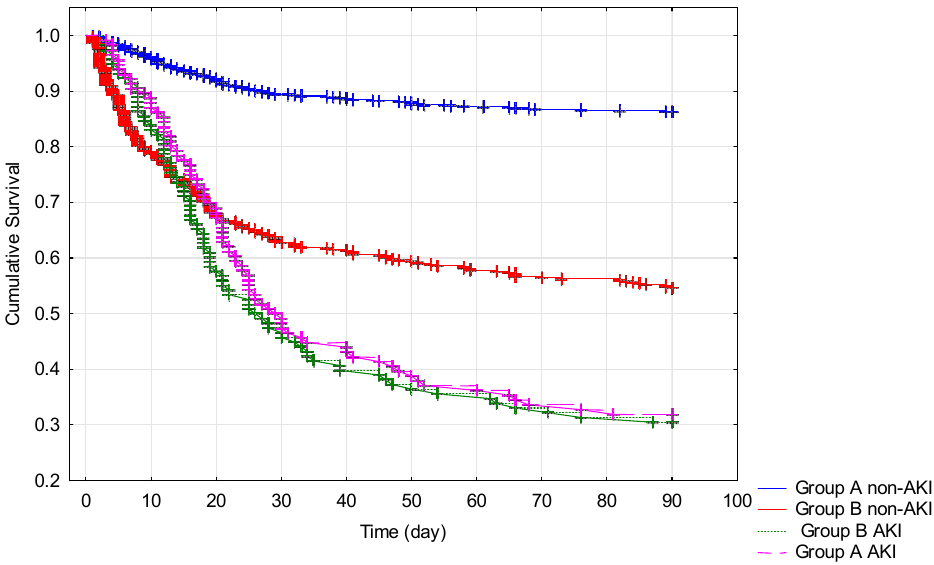
Figure 2. Kaplan–Meier cumulative survival analysis of COVID-19 patients until the 90th day from admission to hospital. All patients were divided into the four groups based on eGFR at admission and the AKI development during hospitaliza- tion. eGFR: Glomerular filtration rate. AKI: Acute kidney injury. Group A: eGFR ≥ 60 mL/min/1.73 m 2 ; group B: eGFR < 60 mL/min/1.73 m 2 . Logarithmic rank analysis showed a statistical difference between the abovementioned four groups ( p < 0.0000). AKI onset during hospitalization was associated with significantly higher mortality in COVID-19 patients inde- pendently from baseline eGFR.